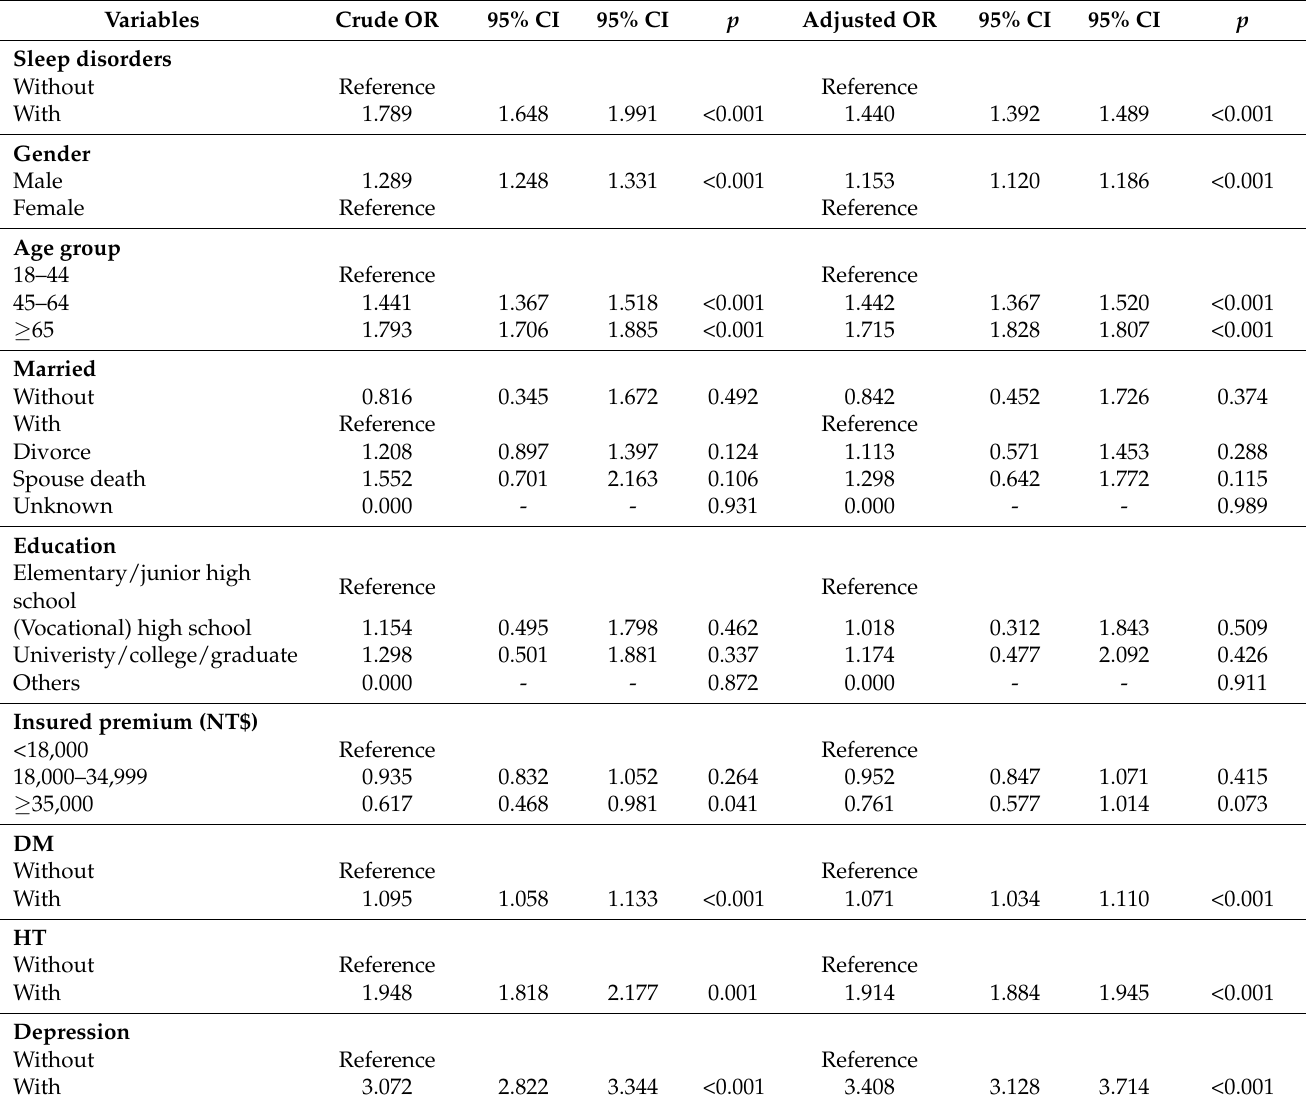
Table 2. Factors of cancers by using conditional logistic